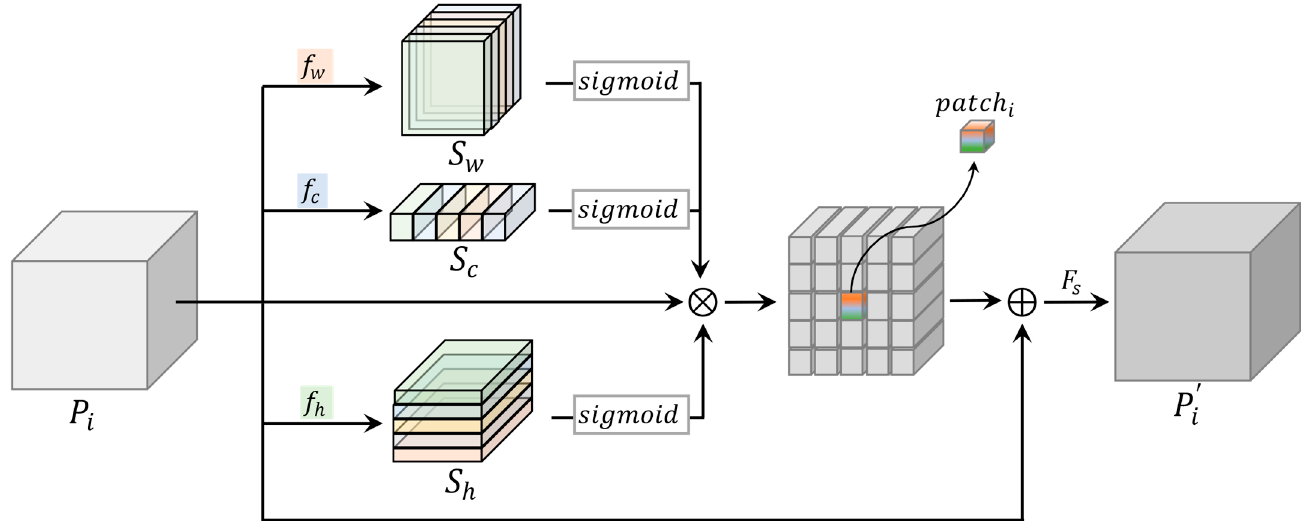
Figure 5. Diagram of the data flow of FISM.